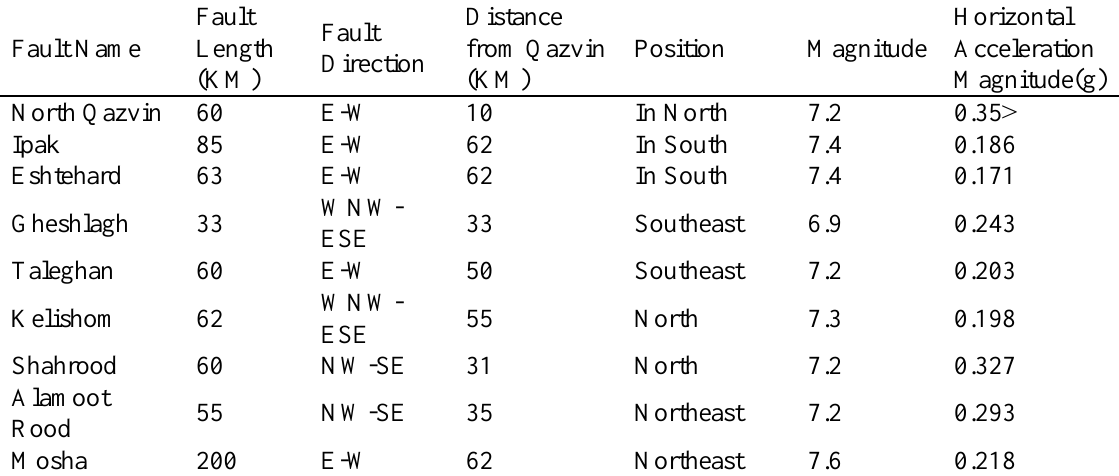
Table 4. Some of the active and seismic faults of Qazvin province (Poursharifi,